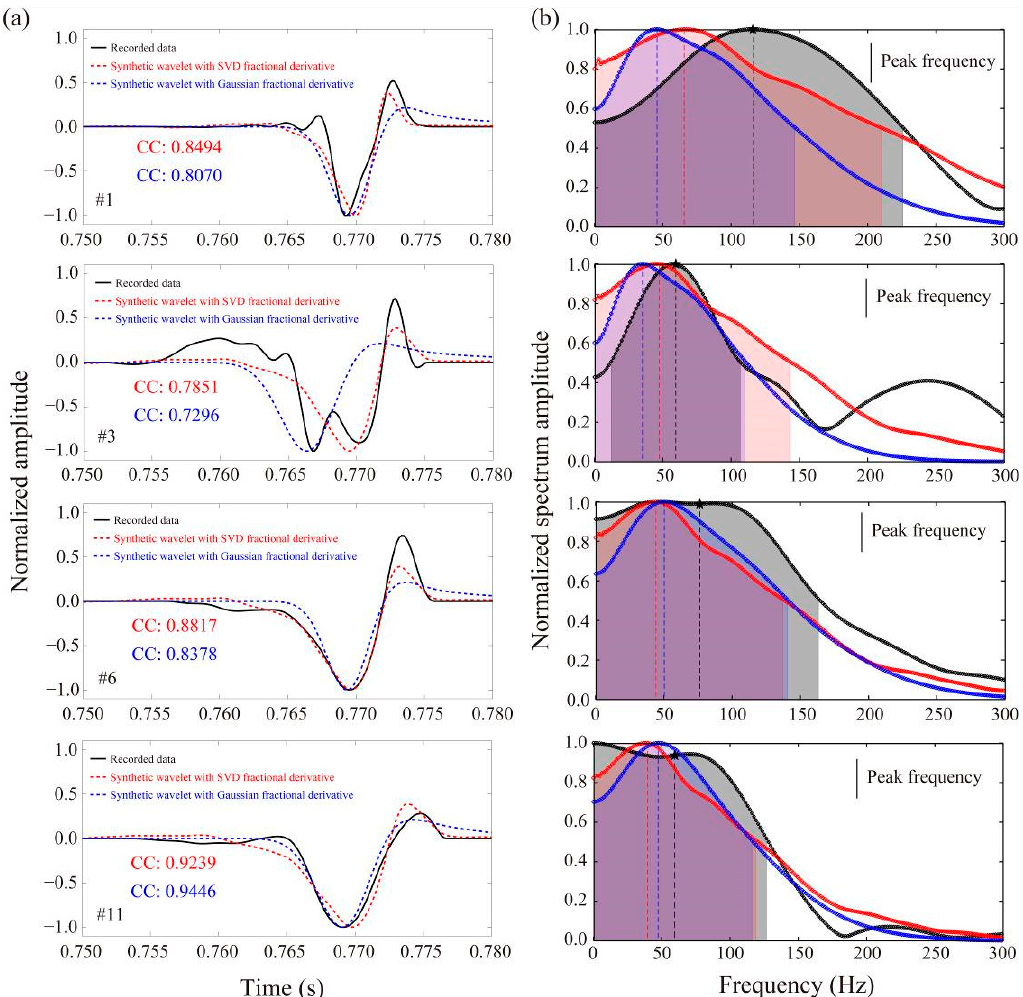
Figure 5. Fitting performance of windowed observed waveforms and synthetic waveforms based on different source-time function estimation approaches and their corresponding amplitude spectra. ( a ) Waveform fitting illustration of synthetic waveforms generated by the data-driven singular value decomposition averaged fractional derivative (DD-SVD-FD) source-time wavelet (red curve) and frictional-order Gaussian source-time function (blue curve). The black curve represents the windowed observed waveforms. The normalized cross-correlation coefficient between DD-SVD-FD source-time function and windowed observed waveform is shown in red text, while the normalized cross-correlation coefficient between frictional-order Gaussian source-time function and windowed observed waveform is shown in blue text. The number corresponds to the renumbering of sensors, which is ranked from early to late according to the initial P phase arrival time. ( b ) Normalized amplitude spectra correspond to the colored waveforms shown in ( a ). The vertical dotted line is the peak frequency and the shaded region shows the half-bandwidth frequency range.